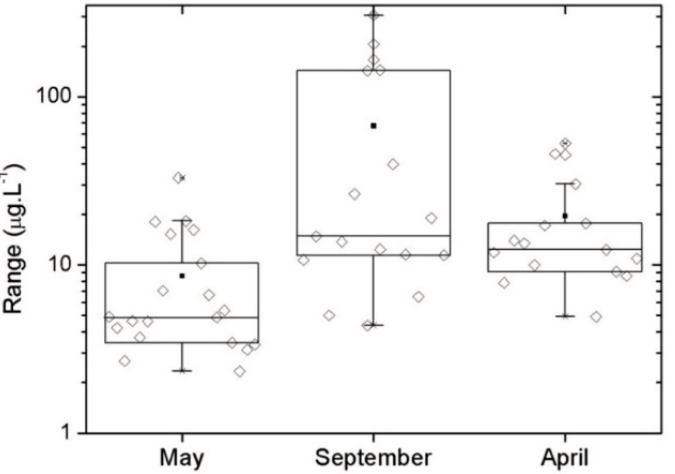
Figure 2. Box-plots with the summary statistics for chl- a (concentrations in µg·L − 1 ) at each